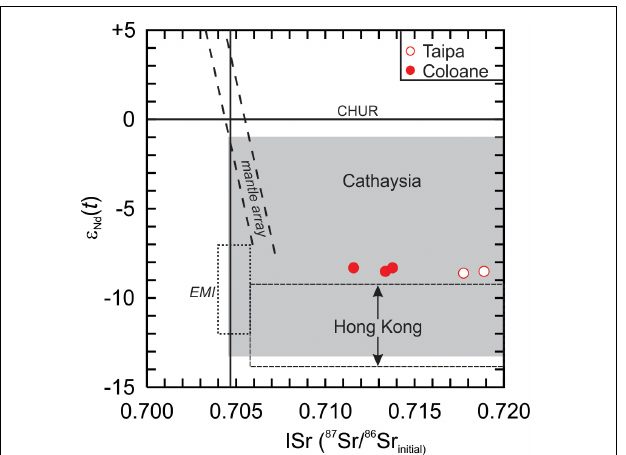
FIGURE 6 | Age corrected Sr-Nd isotopes of the leucogranites from Taipa and Coloane. Range of granitic rocks from the Cathaysia Block in gray (Chen and Jahn, 1998). The Sr-Nd range of Jurassic granitic rocks from Hong Kong (HK) from Darbyshire and Sewell (1997). EMI = enriched mantle I (Zindler and Hart, 1986); CHUR = chondrite uniform